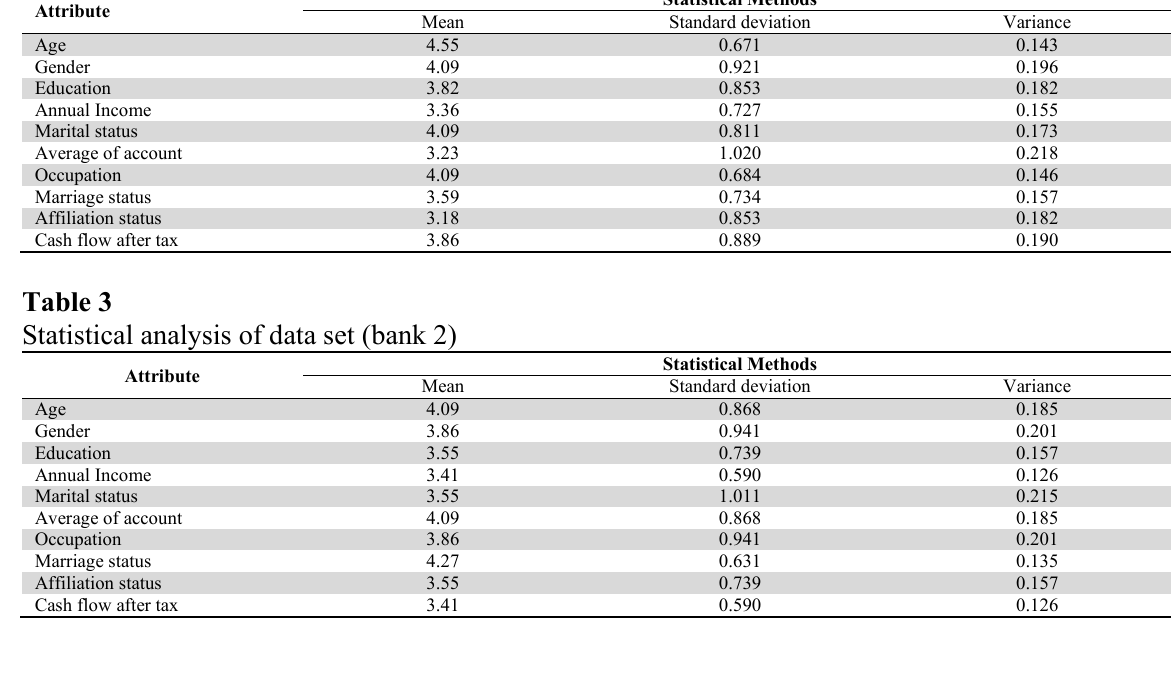
Statistical analysis of data set (bank 1) Attribute